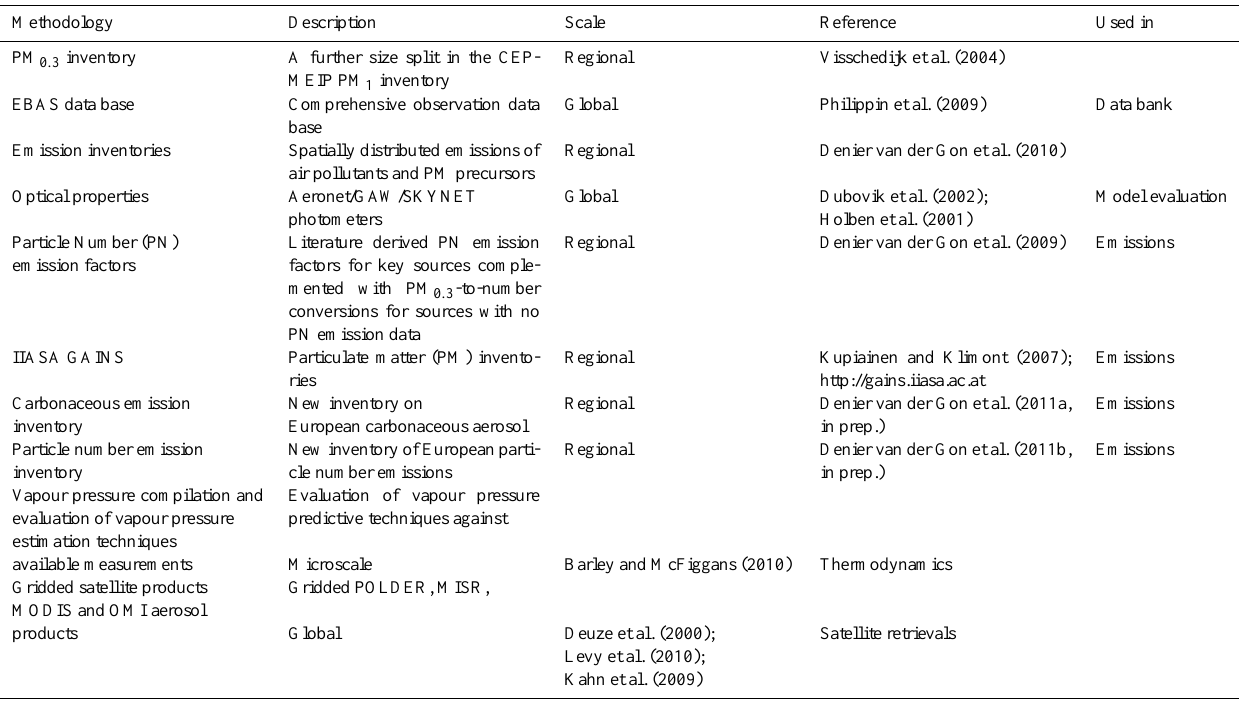
Table A6. Databases and inventories used in EUCAARI.